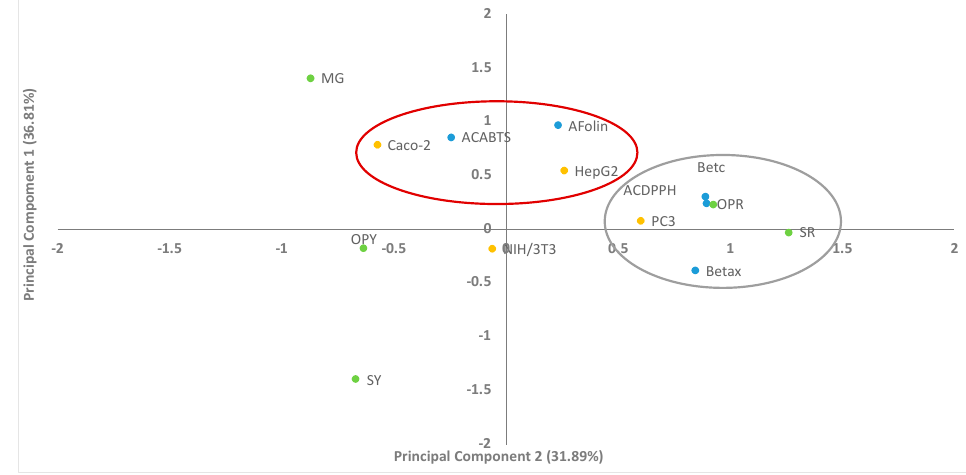
Figure 3. Distribution of five clarified juices along principal components 1 and 2 using nine variables. Betacyanins (Betac), betaxanthins (Betx),antioxidant activity by ABTS method (ACABTS), antioxidant activity by DPPH method (ACDPPH), total phenolic composition (AFolin), fibroblast cell line (NIH/3T3), colon cancer cell line (Caco-2), hepatic cancer cell line (HepG2), prostate cancer cell line (PC3) S tenocereus pruinosus yellow fruit clarified juice(SY) , S tenocereus pruinosus red fruit clarified juice (SR), Opuntia ficus-indica yellow fruit clarified juice (OPY), Opuntia ficus-indica red fruit (OPR) clarified juice, and Myrtillocactus geomettizans fruit (MG) clarified juice. The oranges circles are cancer cell lines, the blue circles are the analytical methods and green circles are the clarified juices